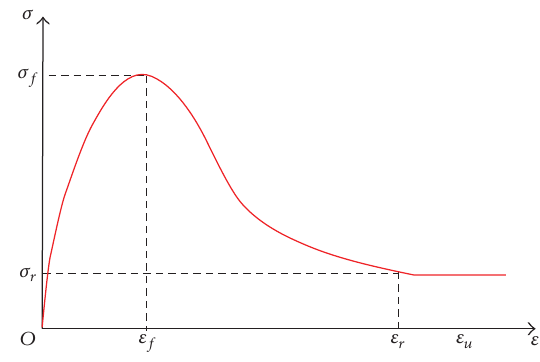
Figure 2: Revised piecewise curve of damage model.